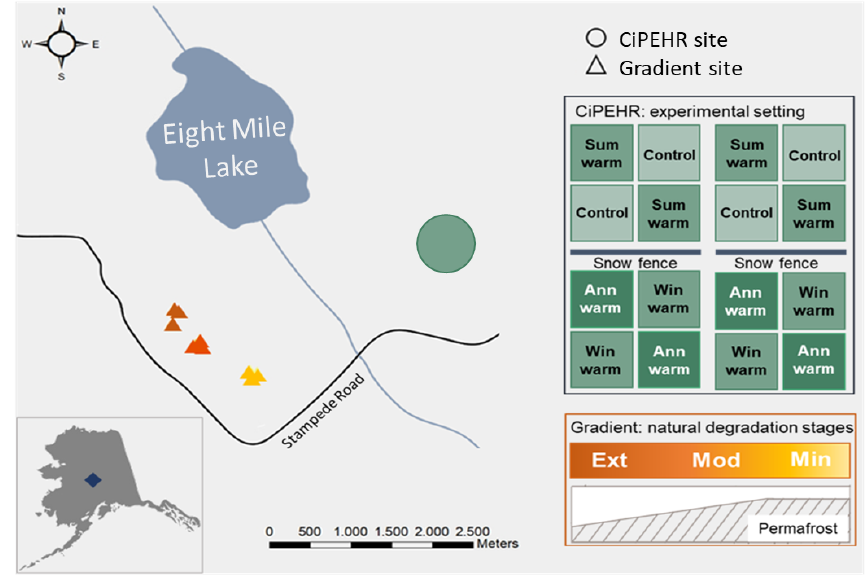
Figure 1. Study site at Eight Mile Lake, in Central Alaska, USA. The experimental CiPEHR site (Carbon in Permafrost Experimental Heating Research, in green) presents four treatments: control, summer air warming (Sum warm) with open top chamber settings, winter soil warming (Win warm) with snow fences that insulate the soil upon snow accumulation, and annual warming (Ann warm) with both air and soil warming. The Gradient site is a natural thermokarst gradient composed of three contrasted areas in terms of permafrost degradation with minimal (Min), moderate (Mod), and extensive (Ext) permafrost degradation (yellow to orange triangles). Source: Esri, HERE, Garmin, OpenStreetMap contributors, and GIS user community (February